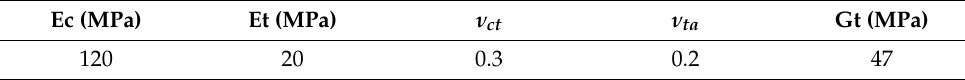
Table 2. Meniscus materials’